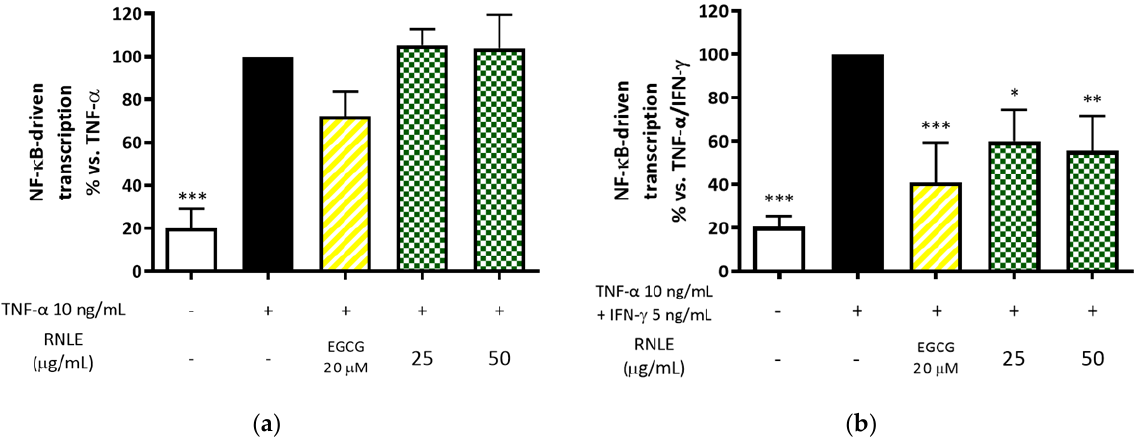
Figure 8. ( a ) Effect of RNLE treatment (25–50 µg/mL) on NF-κB-driven transcription in HaCaT cells stimulated with TNF- α (10 ng/mL, 24 h). ( b ) Effect of RNLE treatment (25–100 µg/mL) on NF-κB-driven transcription in HaCaT cells stimulated with a combination of IFN-γ and TNF-α (5 ng/mL + 10 ng/mL, 24 h). (−)-Epigallocatechin 3-gallate (EGCG) 20 µM was used as the reference compound; * p < 0.05, ** p < 0.01, *** p < 0.001 vs. stimulus.